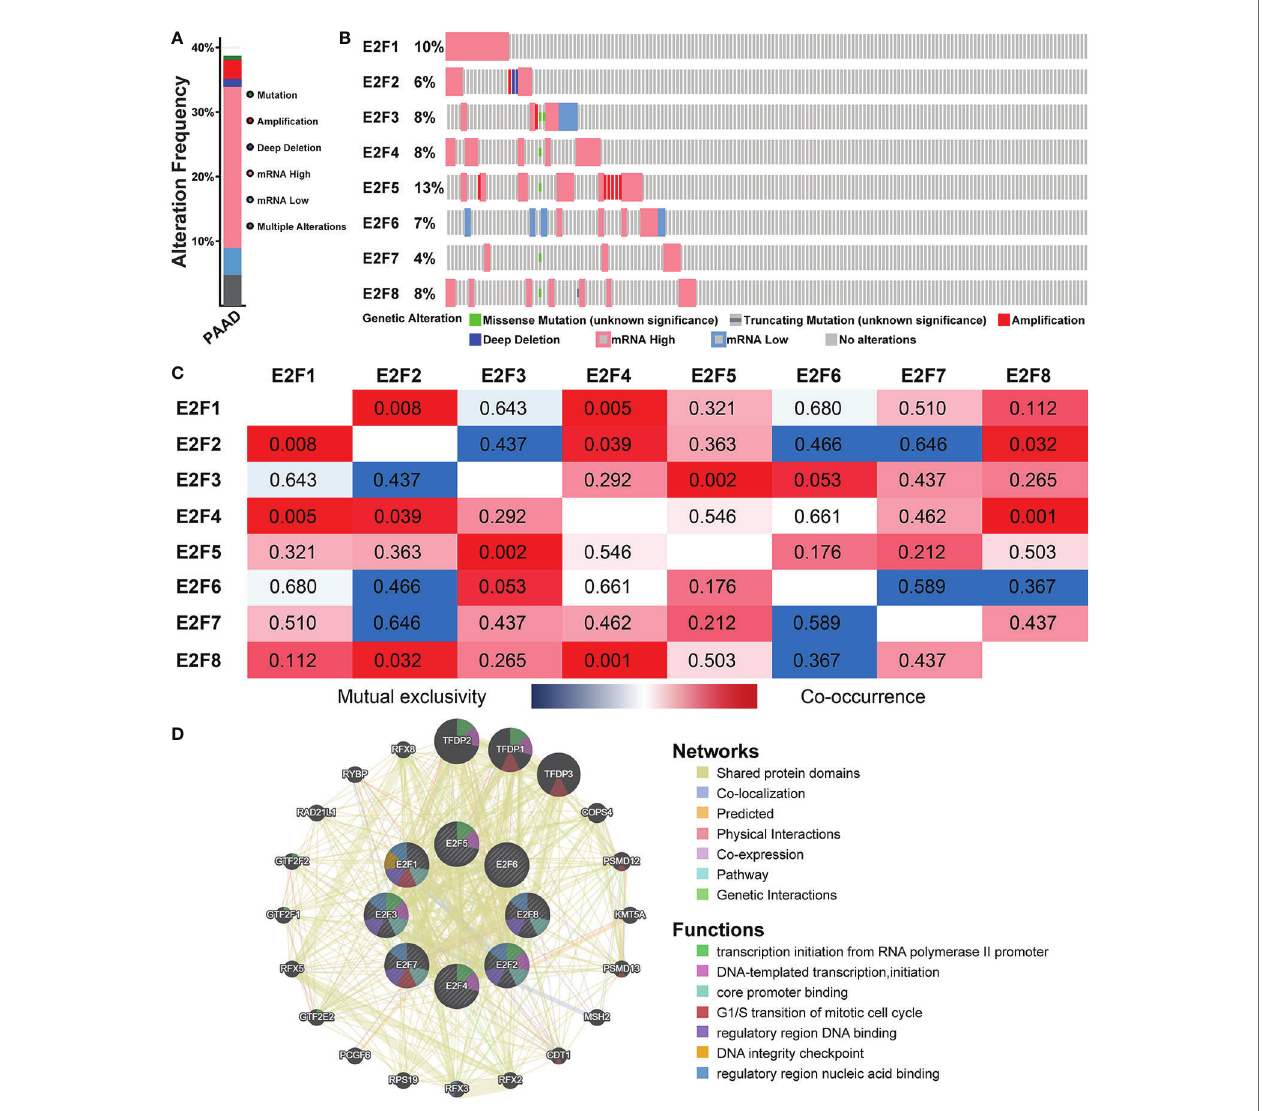
FIGURE 7 | Genetic alteration, co-expression, neighbor gene network, and interaction analyses of E2Fs in patients with PAAD (cBioPortal and GeneMANIA). (A) Summary of alterations in different expressed E2Fs in PAAD. (B) OncoPrint visual summary of alteration on a query of E2F family members. (C) Correlation heat map of different expressed E2Fs in PAAD. Red and blue cells indicate co-occurrence and mutual exclusivity, respectively. The numbers in the color blocks represent the P -values. (D) Gene – gene interaction network of different expressed E2Fs. Each node represents a gene, and the size of the node represents the strength of the interaction. The color of the connection lines between nodes represents the type of gene – gene interaction. Node colors indicate the possible functions of the respective